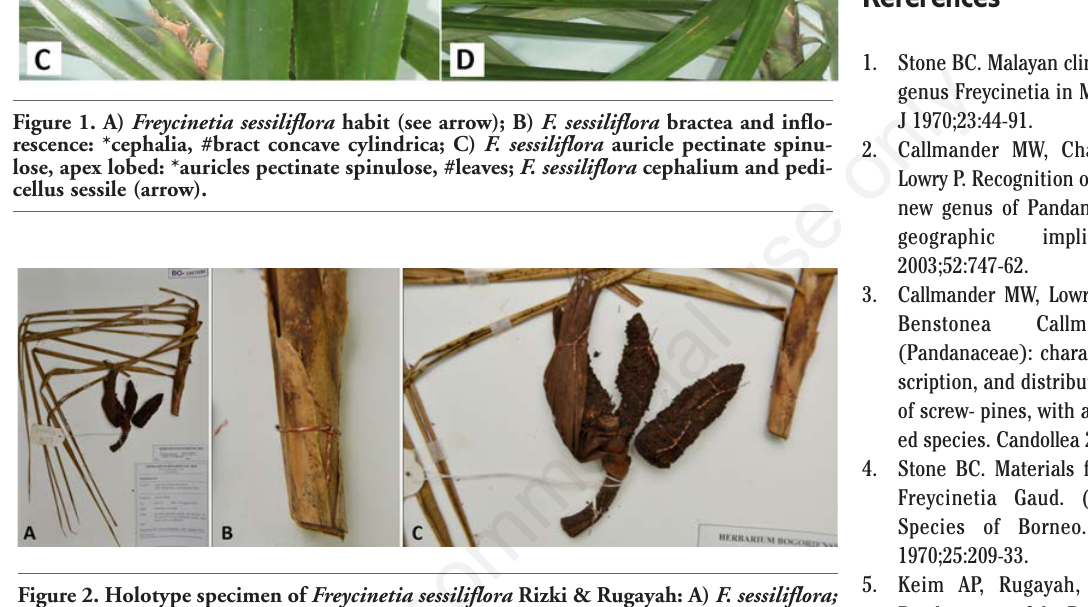
outer 15-20×6-8 cm, inner 1.4-2×6-10 cm, red- orange, margins armed from the base to the apex. Cephalia 2-3, sessile, cylindrical, 6.5- 8×2-2.5 cm long, berry pentagonal, 0.2- 0.5 mm in diameter; stigma remains mostly 2-4, areola stigma with rings, seeds ellipsoid.